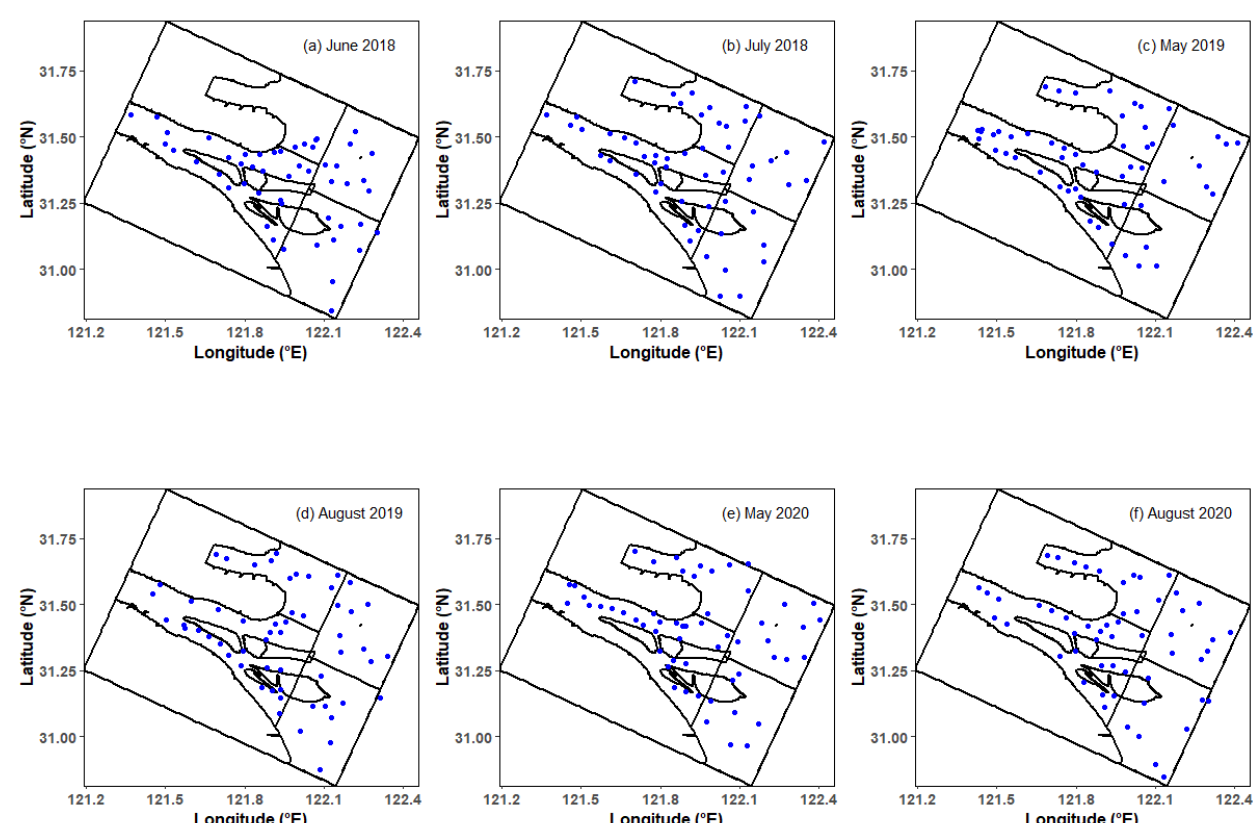
Figure A1. Sampling stations for six cruises in the Yangtze Estuary.